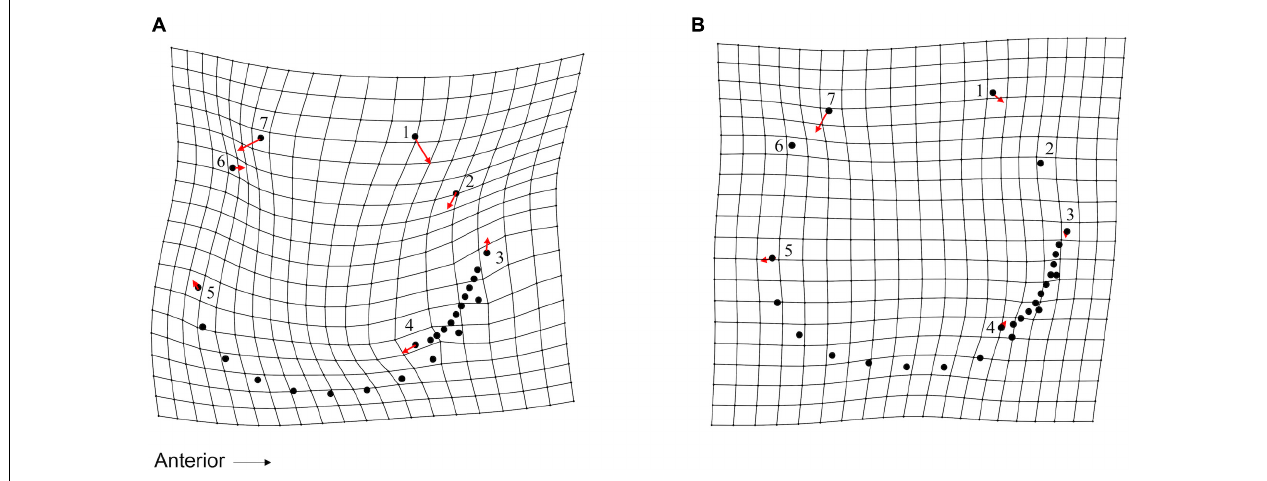
FIGURE 6 | Thin plate spline (TPS) grid, with vectors showing magnitude and direction of LM and SLM deformation, illustrating the shape variation explained along canonical variate axes for live S. floridana in Figure 5B . Each point represents a LM (numbered 1–7, as presented in Figure 2 ) or an SLM (not numbered) with vectors that illustrate magnitude and direction of deformation on (A) canonical variate axis 1 (CV1) (66.57% of variance) from the maximum (seagrass) to minimum (sand) score values and (B) CV2 (33.43% of variance) from the maximum (seagrass) to minimum (transitional) score values.